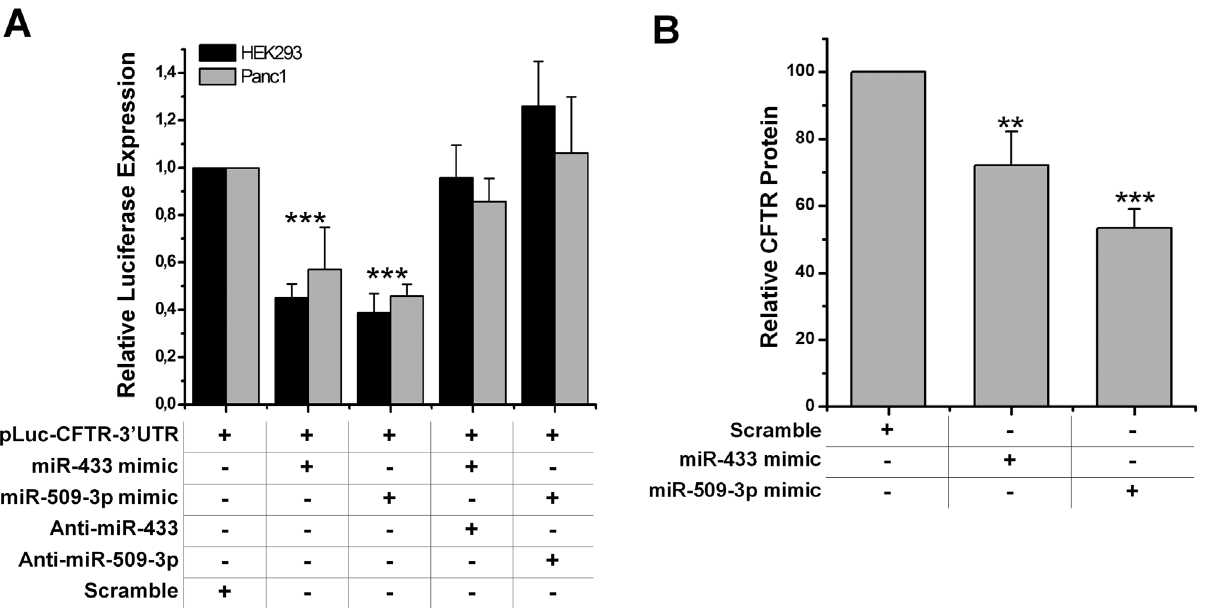
Figure 3. Effect of miR-433 and miR-509-3p on CFTR -3 9 UTR and CFTR protein expression.A : luciferase expression from pLuc-CFTR-3 9 UTR co-transfected with relative miRNA mimics and miRNA mimics plus anti-miRNA both in HEK293 and Panc1 cell lines , ***p , 0.001 B : expression of CFTR protein is decreased to about 25% in Panc1 cells transfected with miR-433 mimic (** p , 0.01) and about 45% in miR-509-3p (*** p , 0.001) transfected cells.